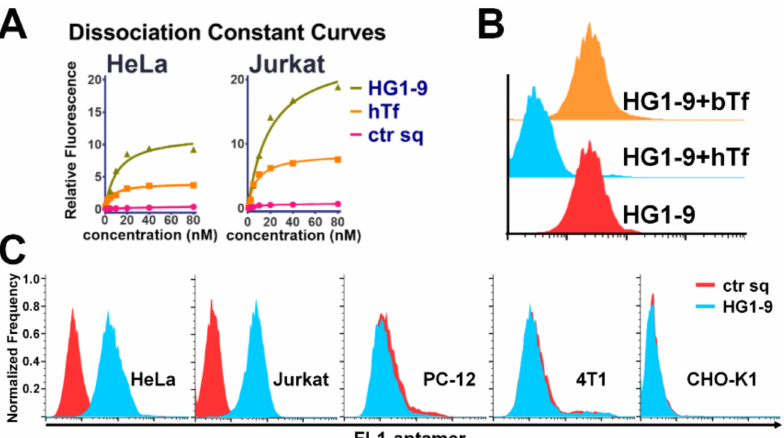
Figure 5. Comparison of hTf and aptamer HG1-9. ( A ) The dissociation constant curves of HG1-9 (labeled by FITC) and hTf (labeled by FITC) to Jurkat and HeLa cells, ctr sq was as the negative control. ( B ) Binding ability of HG1-9 (labeled by FITC, 200 nM) to HeLa cells under the competition of bovine Transferrin (bTf, 500 nM) or human Transferrin (hTf, 500 nM). ( C ) The binding of HG1-9 to human cancer cell lines (HeLa and Jurkat), and other cell lines (PC-12 (Rat adrenal pheochromocytoma), 4T1 (Mouse mammary carcinoma), and CHO-K1 (a subclone of Chinese hamster ovary